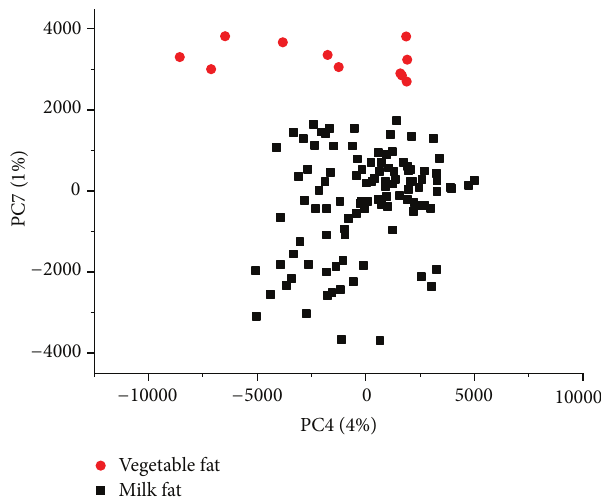
Figure 4: Scatter plot of the PCA 1 H NMR scores in the 3.0– 0.25 ppm region for ice cream samples.